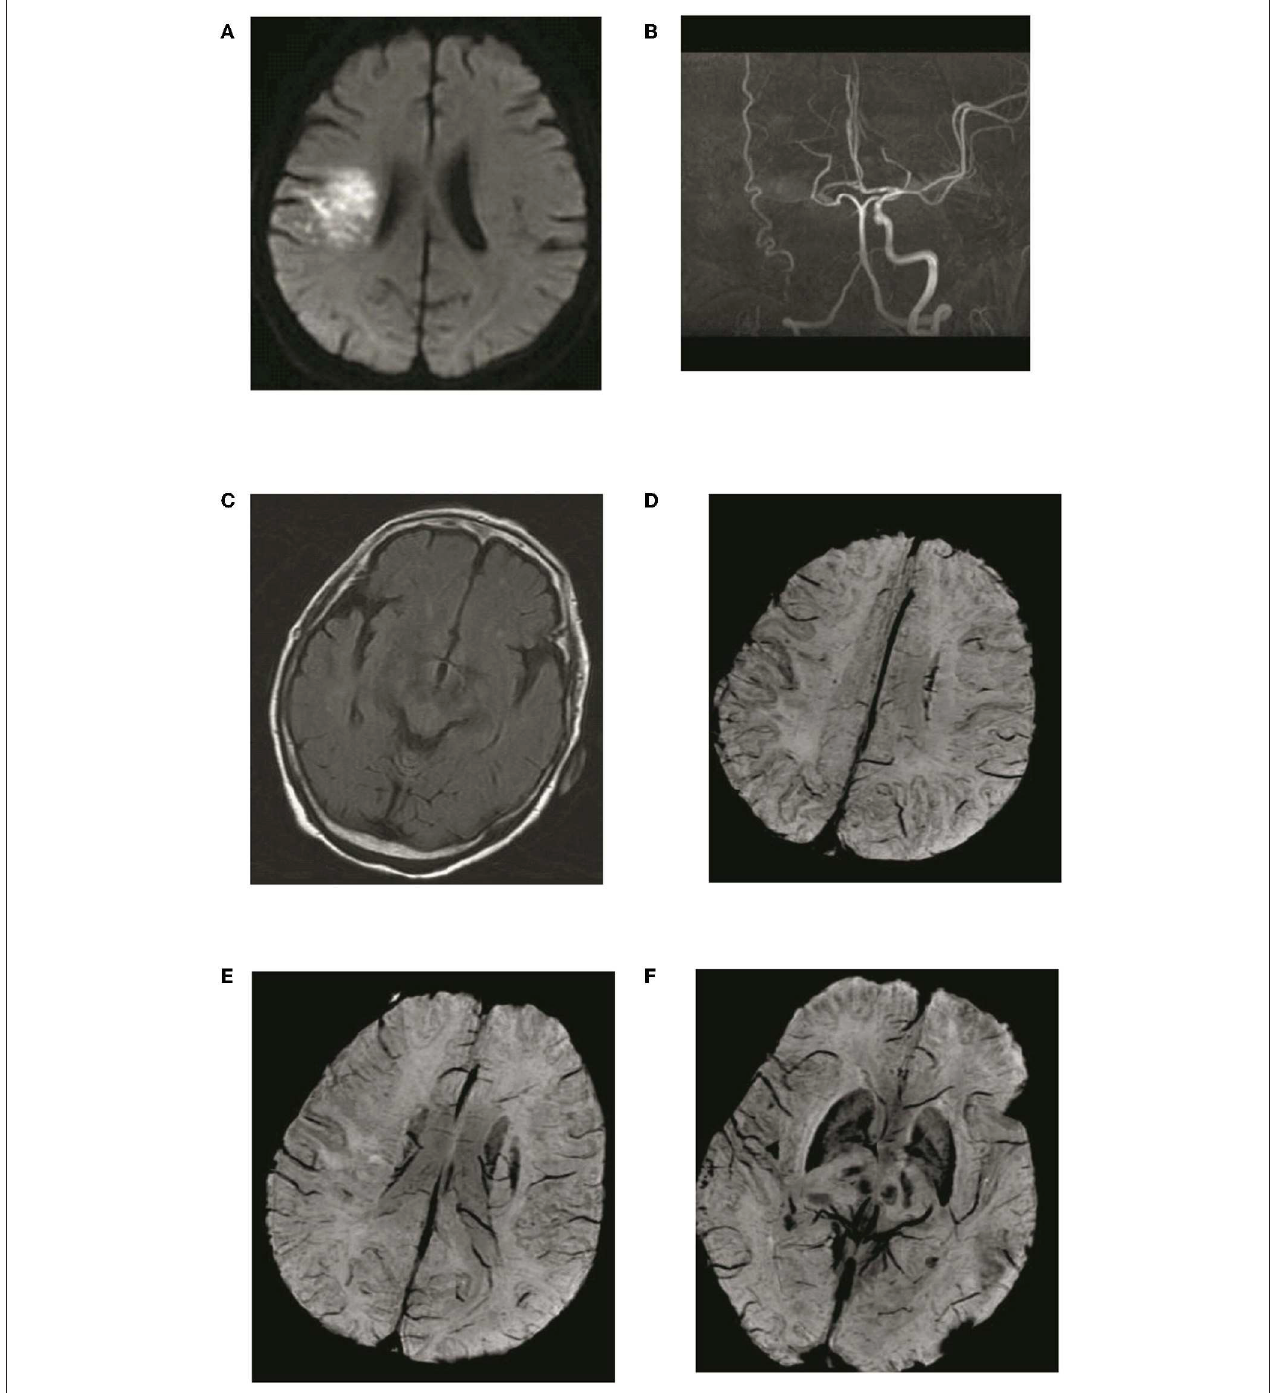
FIGURE 4 | Typical patient with absence of asymmetric deep medullary veins (ADMV). A 69-year-old female presented with left limb weakness for 5h. (A) The right parietal lobe shows acute corona radiata cerebral infarction on DWI; (B) Occlusion of the right internal carotid artery on magnetic resonance angiography with maximal intensity projection; (C) HVS with a score of 0 on T2-FLAIR image: (D) Absence of ADMV; (E,F) ACV with a score of 2 on SWI.